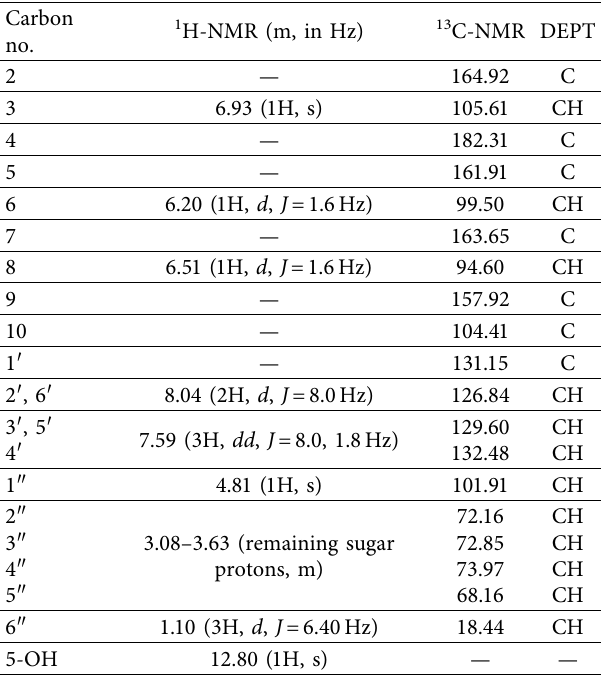
Table 3: 1 H-NMR, 13 C-NMR, and DEPT (400 and 100MHz, DMSO- d 6 ) data of compound (10)